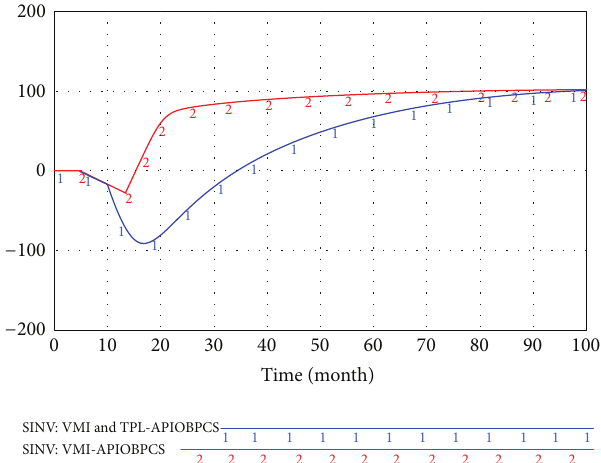
Figure 15: The comparison of system inventory level fluctuation.